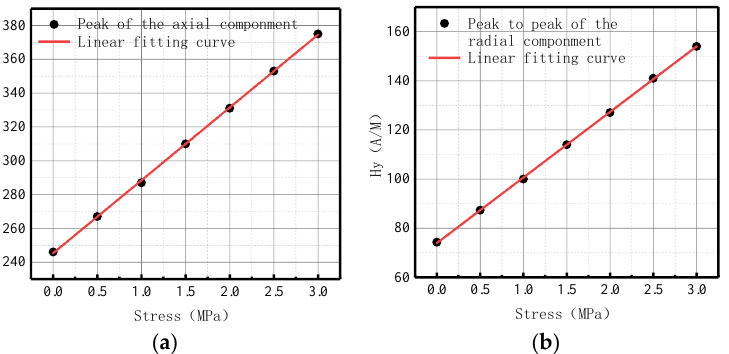
Figure 8. Peak values of weak magnetic signal at weld varies with internal pressures. ( a ) Peak values of the axial component; ( b ) peak-to-peak values of the radial component.